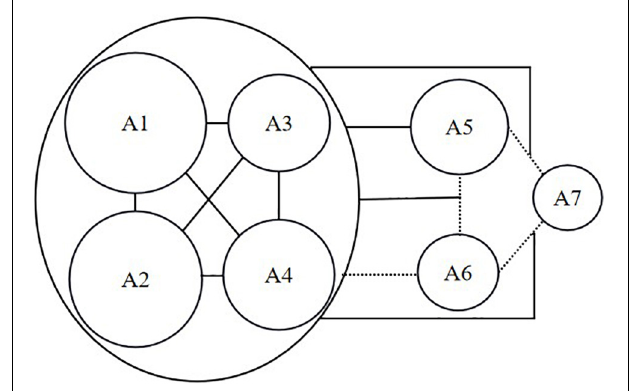
TABLE 9 | Ten dominant latent classes and posterior probabilities.